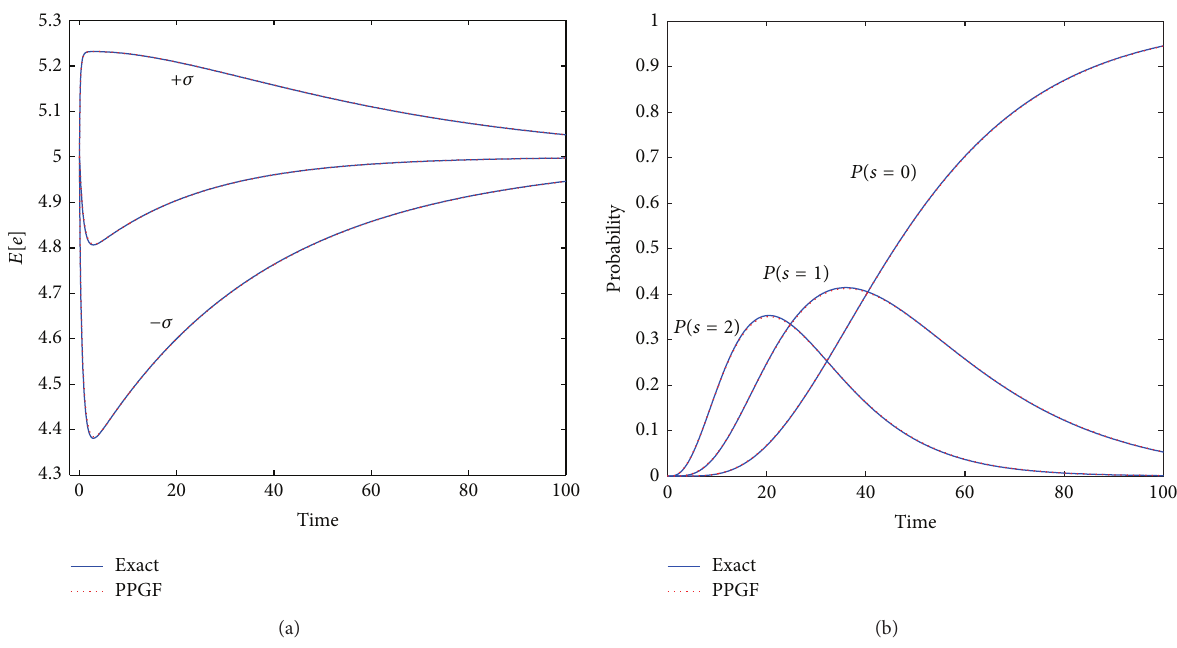
Figure 1: Comparison of mean, standard deviation and marginal probability for the enzyme-substrate model. In the three figures, we assume that 𝑛 1 (0) = 5 , 𝑛 2 (0) = 5 , and 𝐴 = 5 . (a) shows the comparison of exact values and approximate values obtained from the PPGF method for mean and mean ± standard deviations ( ±𝜎 ) of 𝑛 1 and (b) shows the comparison of the exact probability and the approximate probability obtained from the PPGF method. In the figure, 𝑃(𝑠 = 𝑖) denotes the probability that the number 𝑛 2 of the substrate is 𝑖 . The exact probability, mean, and variance are obtained by rewriting (15) into the linear ODE system 𝑑𝑝/𝑑𝑡 = 𝐾𝑝 under the given initial condition and then solving it by